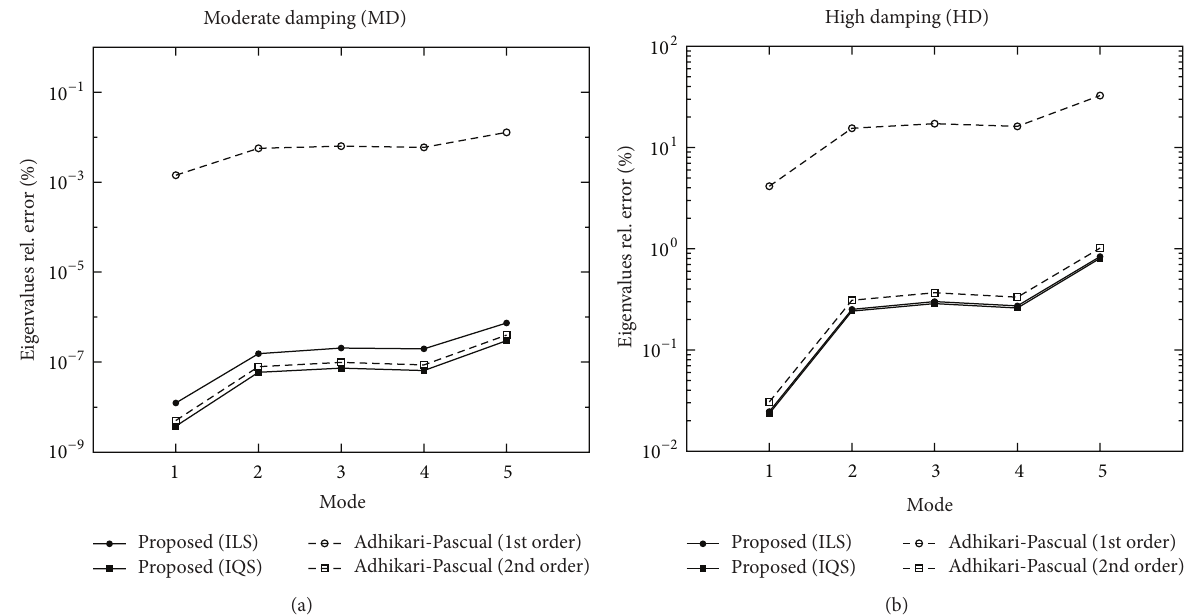
Figure 8: Relative error in the computation of eigenvalues: proposed (solid lines) and Adhikari-Pascual [18] (dashed lines). (a) Moderate damping. (b) High damping.